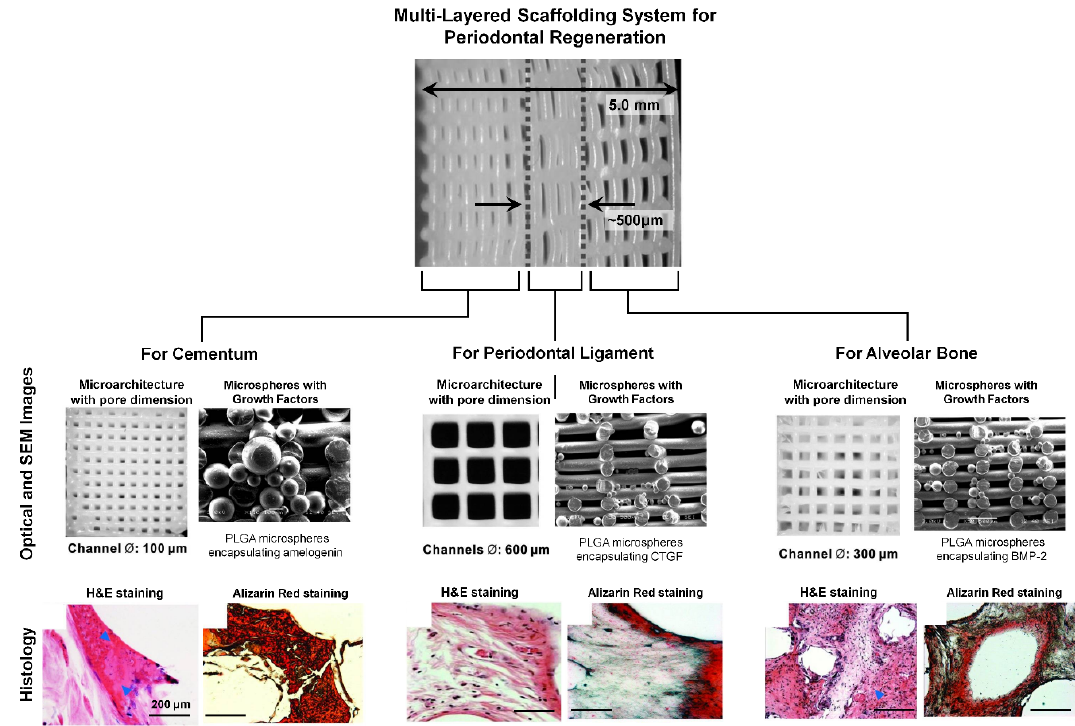
Figure 10. Optical and scanning electron microscopic (SEM) images of 3D printed scaffold